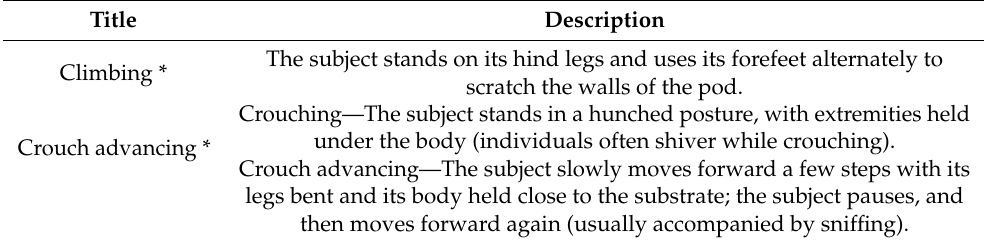
Figure 1. Drawing and photograph of the set-up of observational tunnels as a novel tunnel system for naked mole-rat behavioral tests. Table 1. An ethogram for observed naked mole-rat behavioral acts described by Lacey et al. [35] during personality